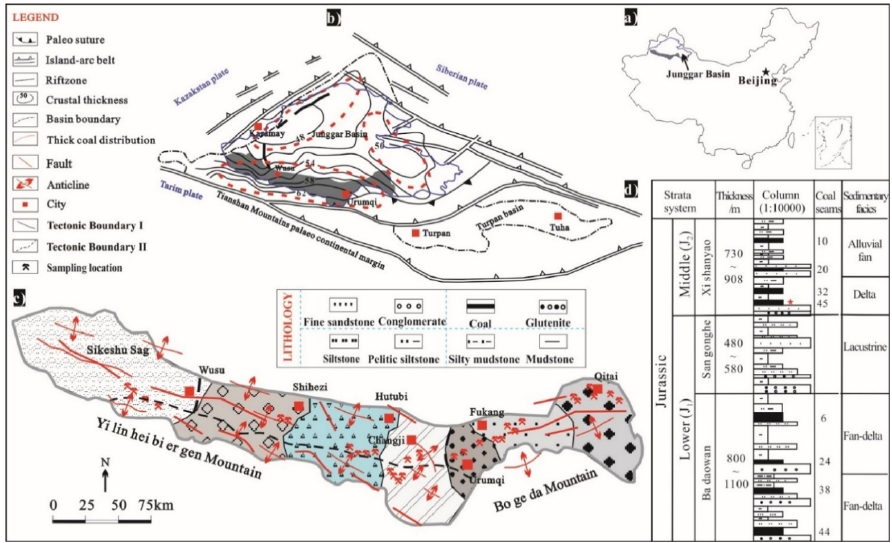
Figure 1. Geological map, sampling locations, and the generalized stratigraphic sequence of the southern Junggar Coalfield, NW China. ( a ) Geographic site of the Junggar Basin; ( b ) structural architecture of the Junggar basin; ( c ) locations of 30 coal samples and seven coalbed methane (CBM) blocks in the southern Junggar Coalfield; and ( d ) coal stratigraphy for geologic age, coal seams, and thickness of coal seams as well as coal sample siting. The target coal seam is No. 45 and all samples were collected from this coalbed.